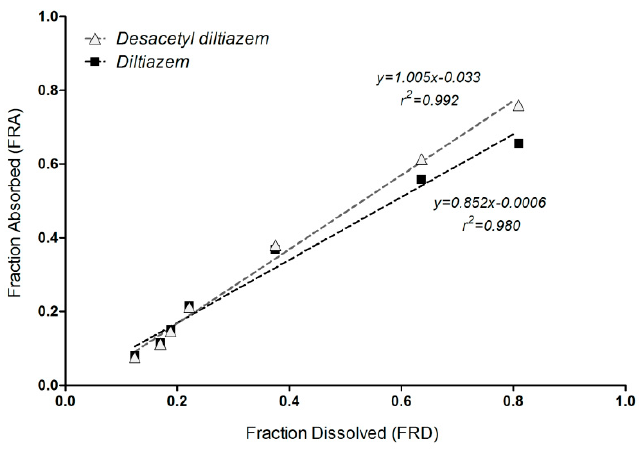
Figure 8. In vitro–in vivo correlation (IVIVC) model for DTZ ( ■ ) and DTZM ( ).